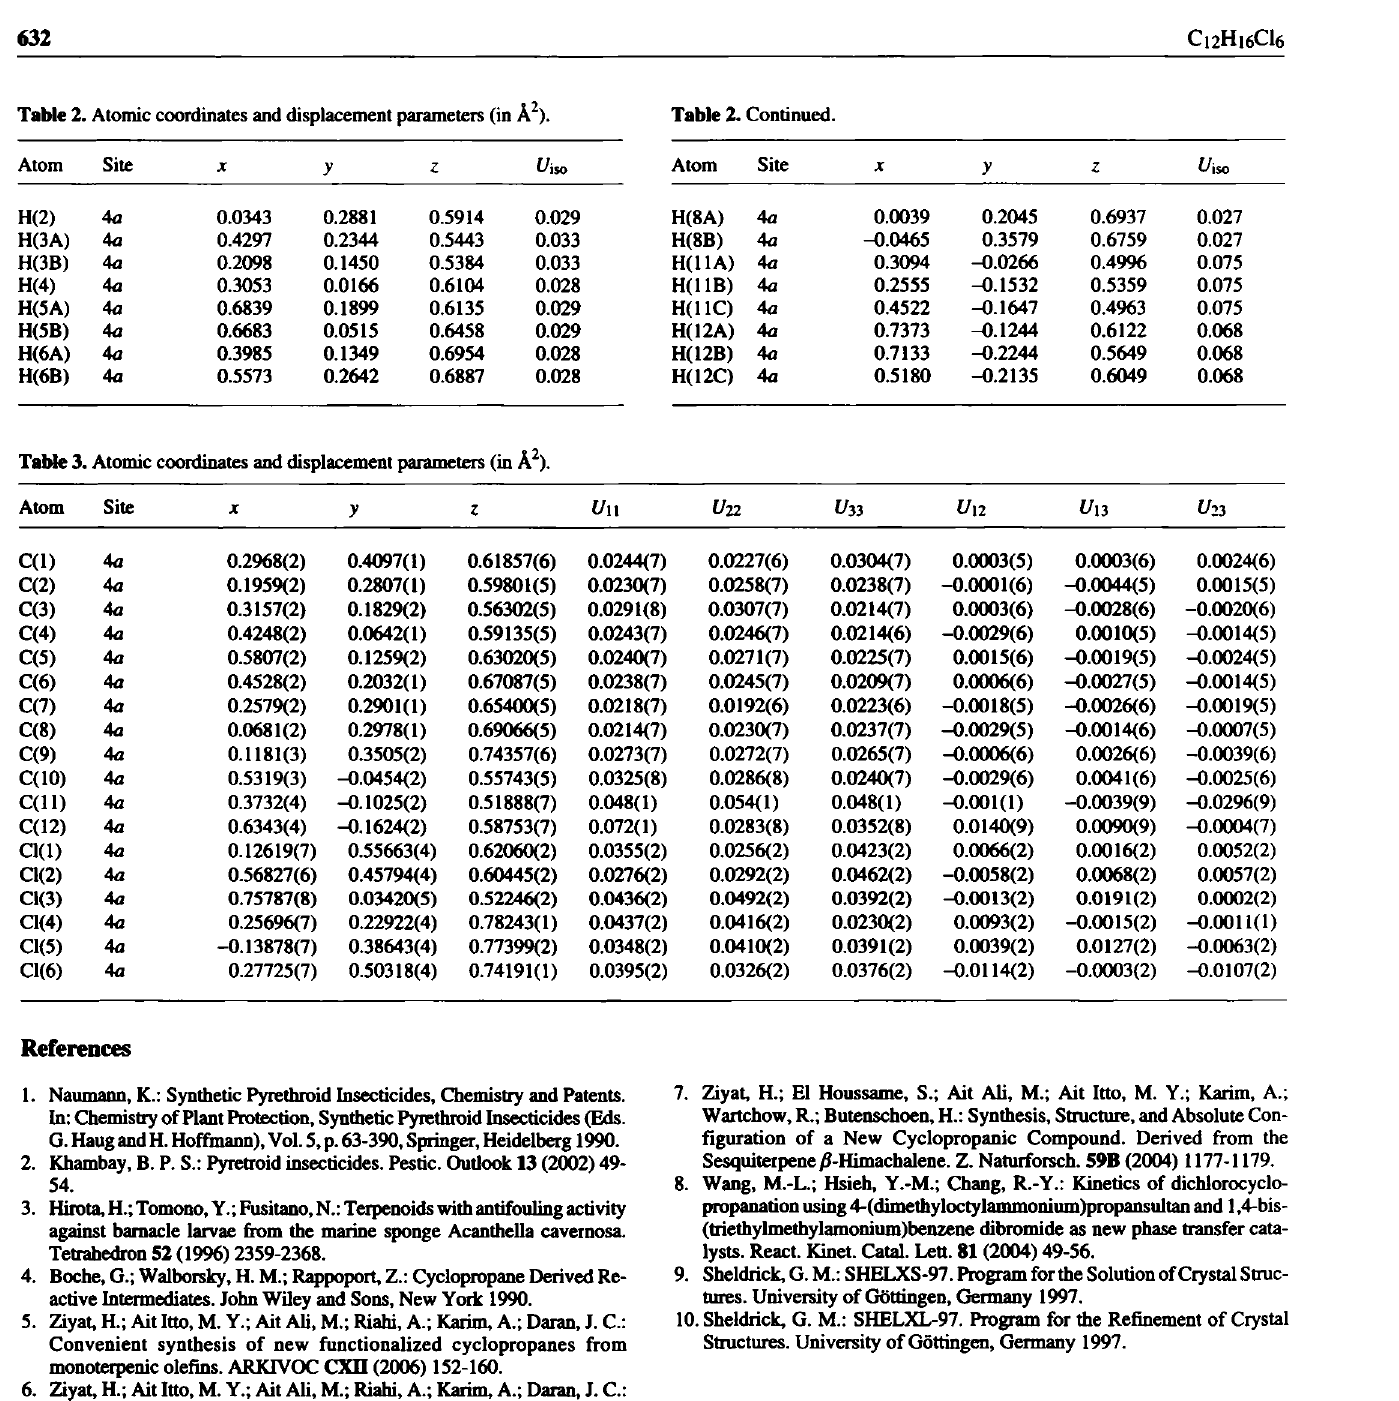
Table 2. Atomic coordinates and displacement parameters (in Â 2 ).